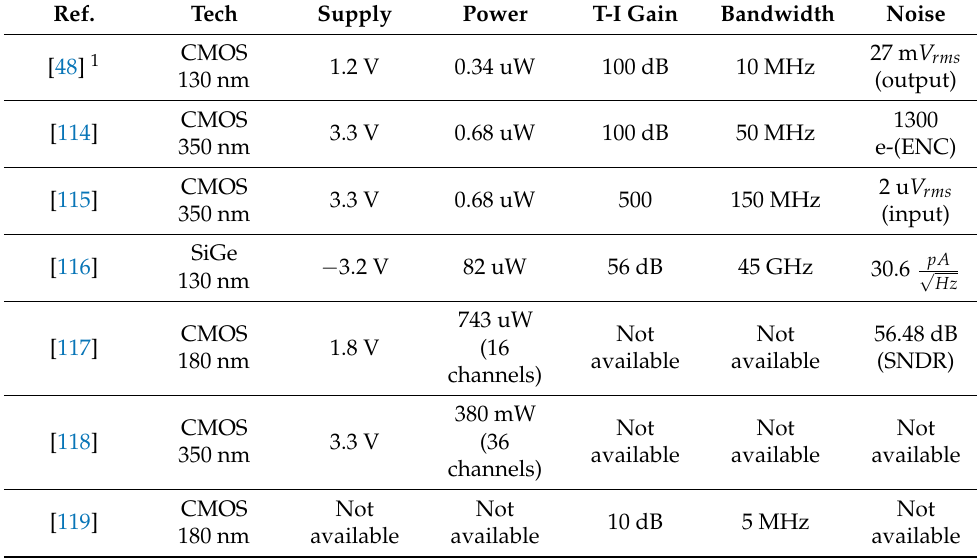
Table 3. Comparison between current-mode SiPM read-out circuits and conventional ones.